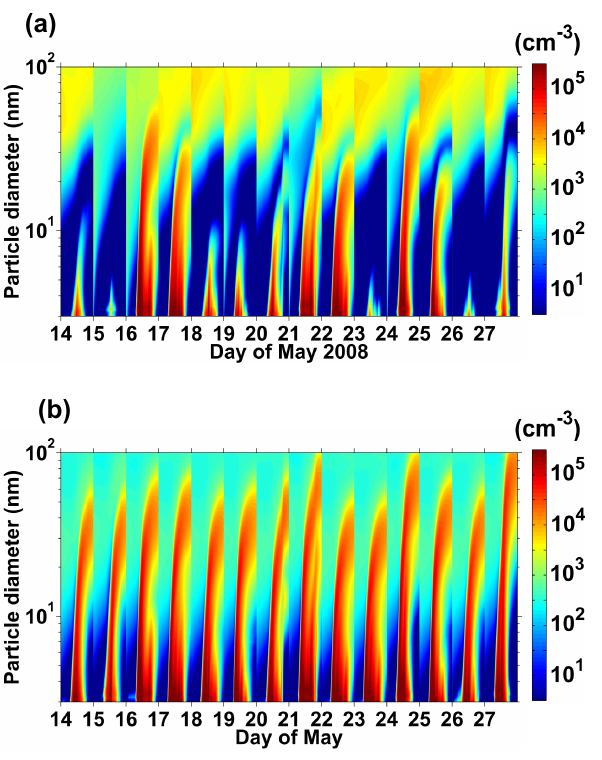
Fig. 10. Simulated particle number size distribution [cm − 3 ], ex- pressed as d N /dLog D p . Model simulations were performed using 250 sections to match the size resolution of the SMPS. The model was initialized every day at 00:00 LST using (a) the measured PSD and (b) the PSD representative of clear atmospheric conditions as described in Seigneur et al. (1986).